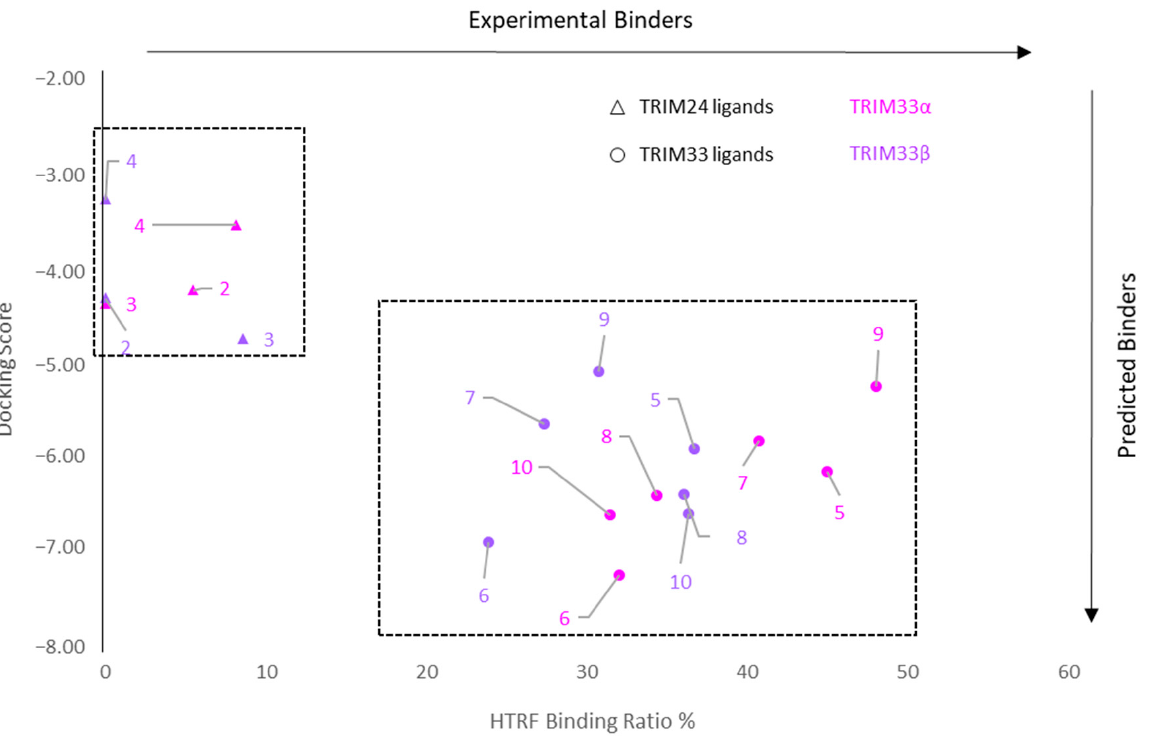
Figure 13. Correlation plot between the predicted binders (docking score) and experimental binders (detected HTRF signal). TRIM24 known ligands show as a triangle, and TRIM33 ligands show as round.